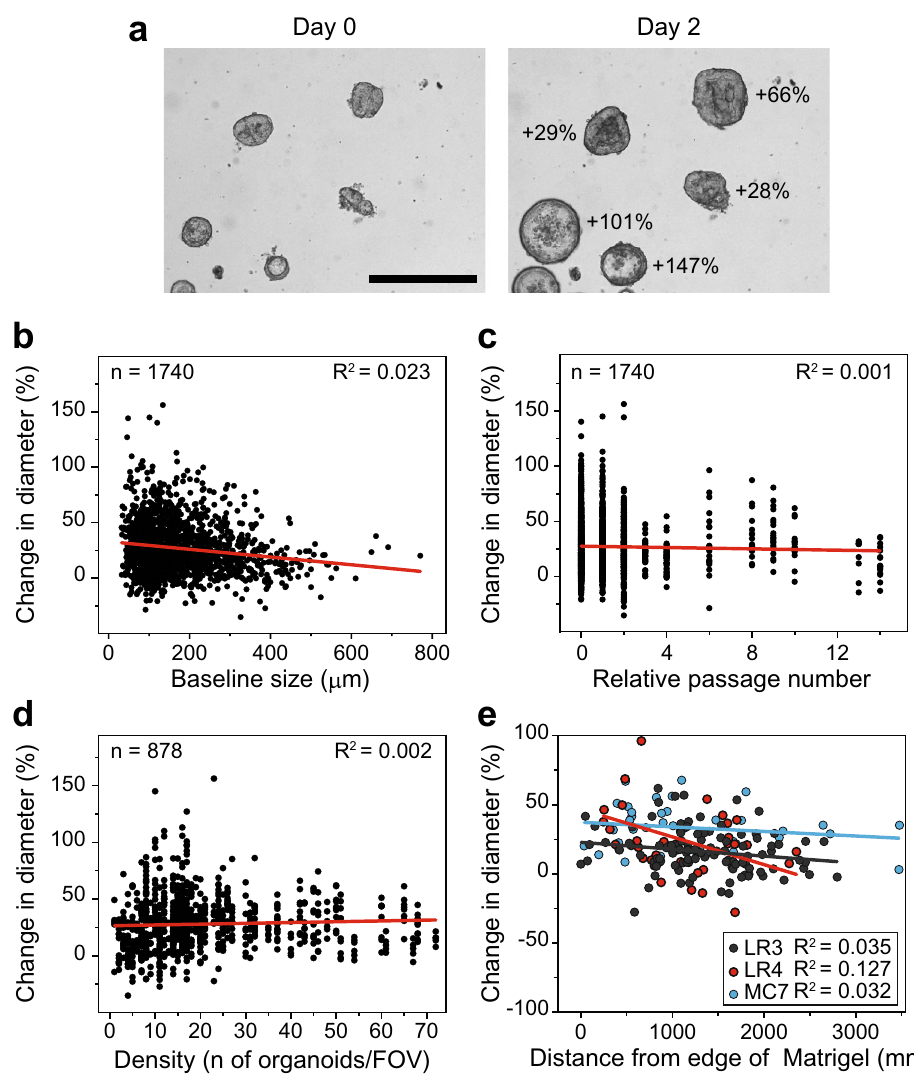
Figure 6. Growth of patient derived cancer organoids is heterogeneous and not affected by baseline culture conditions. Representative image of the heterogeneous growth rates of PDCOs within a culture over 48 h ( a ). Scatter plots display individual organoids’ baseline diameter size (µm) ( b ), relative passage number ( c ), and PDCOs per field of view ( d ) vs their change in diameter (n = 1740, n = 1740, n = 878, respectively). Scatter plots of three CRC PDCO lines location within the Matrigel droplet vs their changes in diameter (LR3 n = 213, LR4 n = 82, and MC7 n = 136). Glass’s delta was calculated to determine the effect size of the change in diameter vs location in the Matrigel droplet for each PDCO line. ( e ) Representative images from ( a ) are shown at the same magnification. Size bar, 500